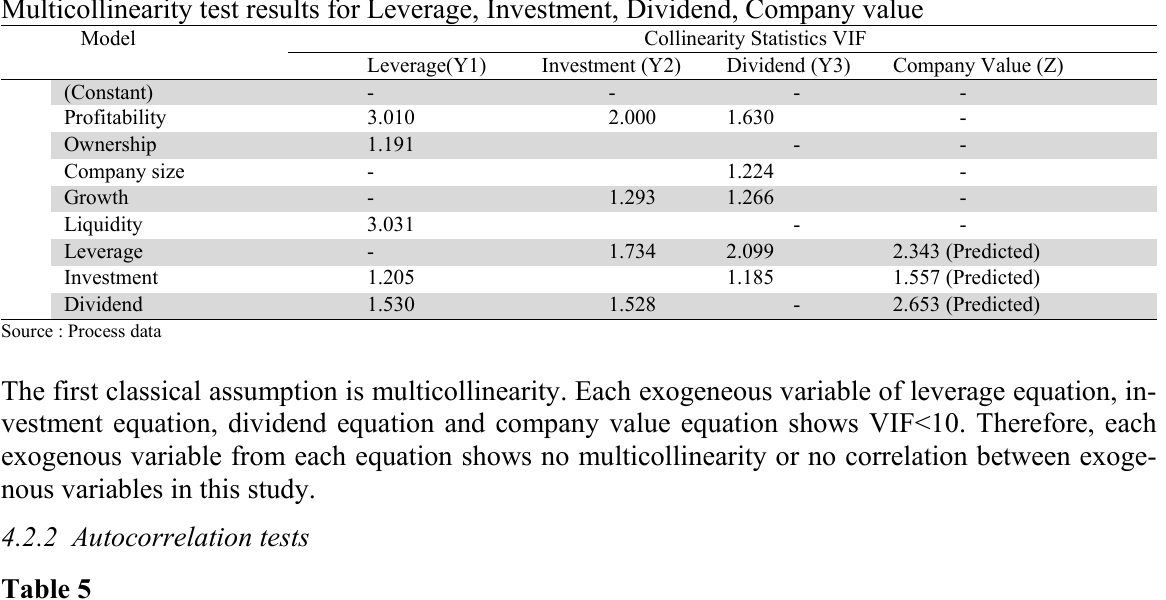
Test results of autocorrelation equation Leverage, Investment, Dividend, Company value